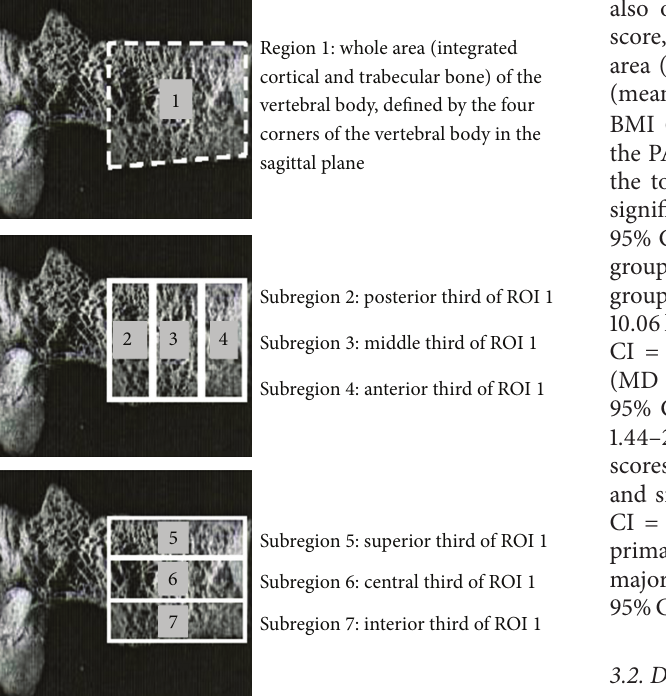
Figure 1: DXA-derived vertebral subregions defined using Hologic software. ROI 1 (whole) was defined by the four corners of the vertebra. ROIs 2–4 (posterior, middle, and anterior) formed equal thirds in the area of ROI 1, oriented sagittally. ROIs 5–7 (superior, central, and inferior) formed equal thirds in area of ROI 1, oriented transversely. Reprinted from Briggs et al. [42] with permission from Elsevier Copyright Clearance